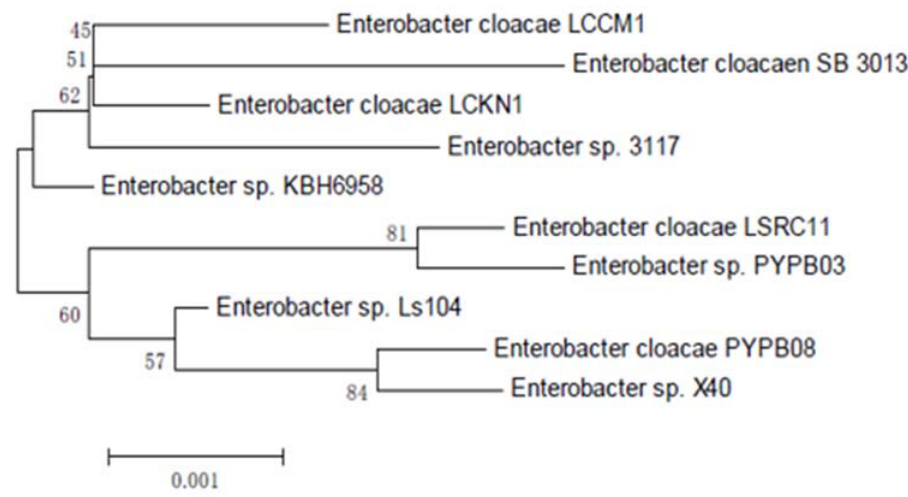
Figure 2. Phylogenetic dendrogram constructed using the neighbor-joining method based on 16s rRNA sequences indicating the position of isolate KBH 6958 among closely related members of the genus Enterobacter . The numbers at the nodes indicate the levels of bootstrap support percentages of 1000 replicates.